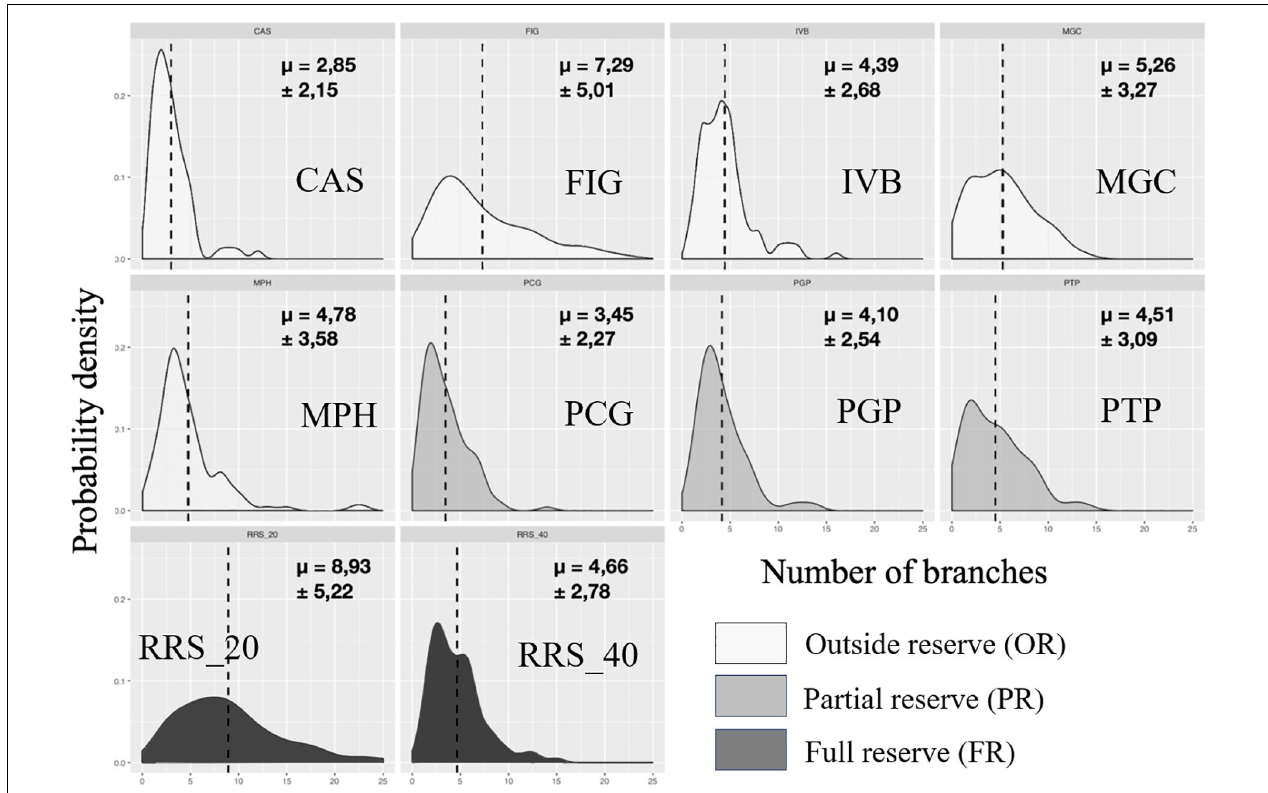
FIGURE 7 | Calanques national park: representation of probability density functions by population of each site for the variable number of branches in 2020. The values indicated correspond to the means followed by the standard deviations. In dark the populations in full reserve (RRS_20; RRS_40), in medium the populations in partial reserve (PTP, PGP, PTP), in clear the populations outside the reserve (MPH, CAS, FIG, IVB,